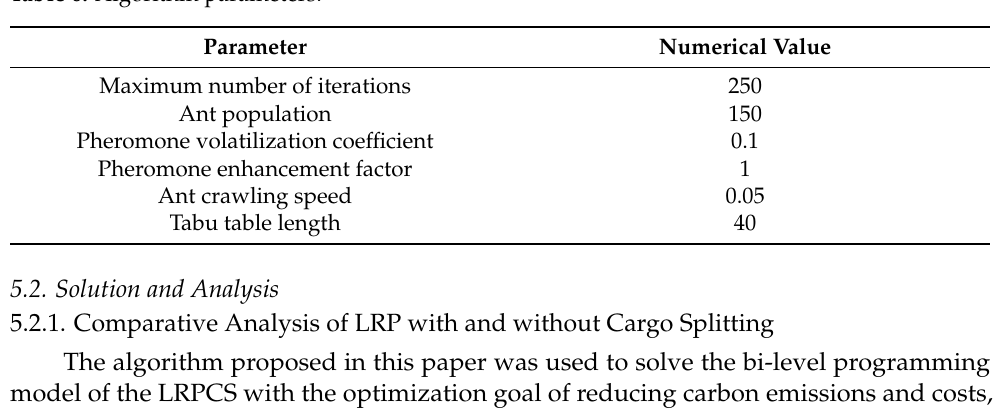
Table 6. Algorithm